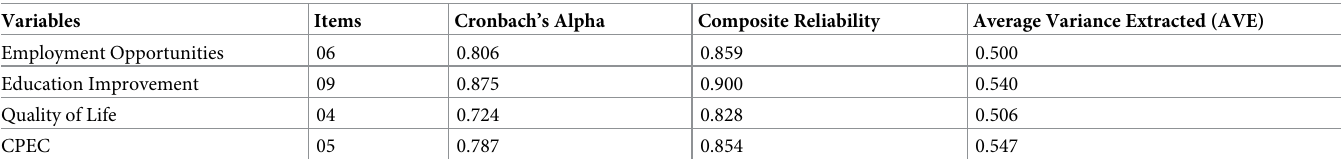
Table 3. Reliability and